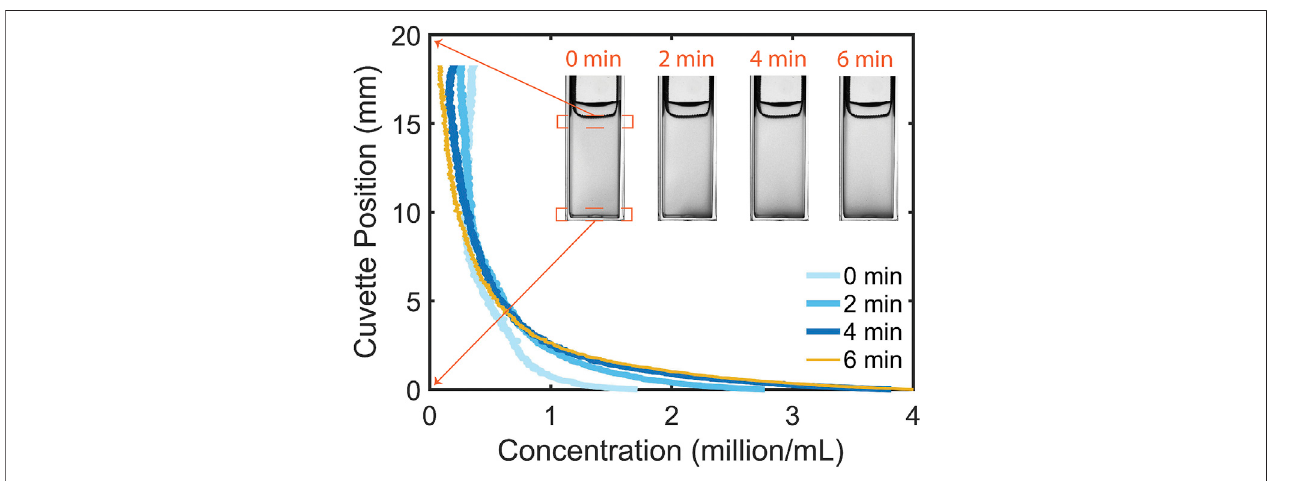
FIGURE 2 | In the absence of phototactic illumination from above microalgae redistribute over the height of the cuvette. A steady distribution can be seen to arise after 4 min.